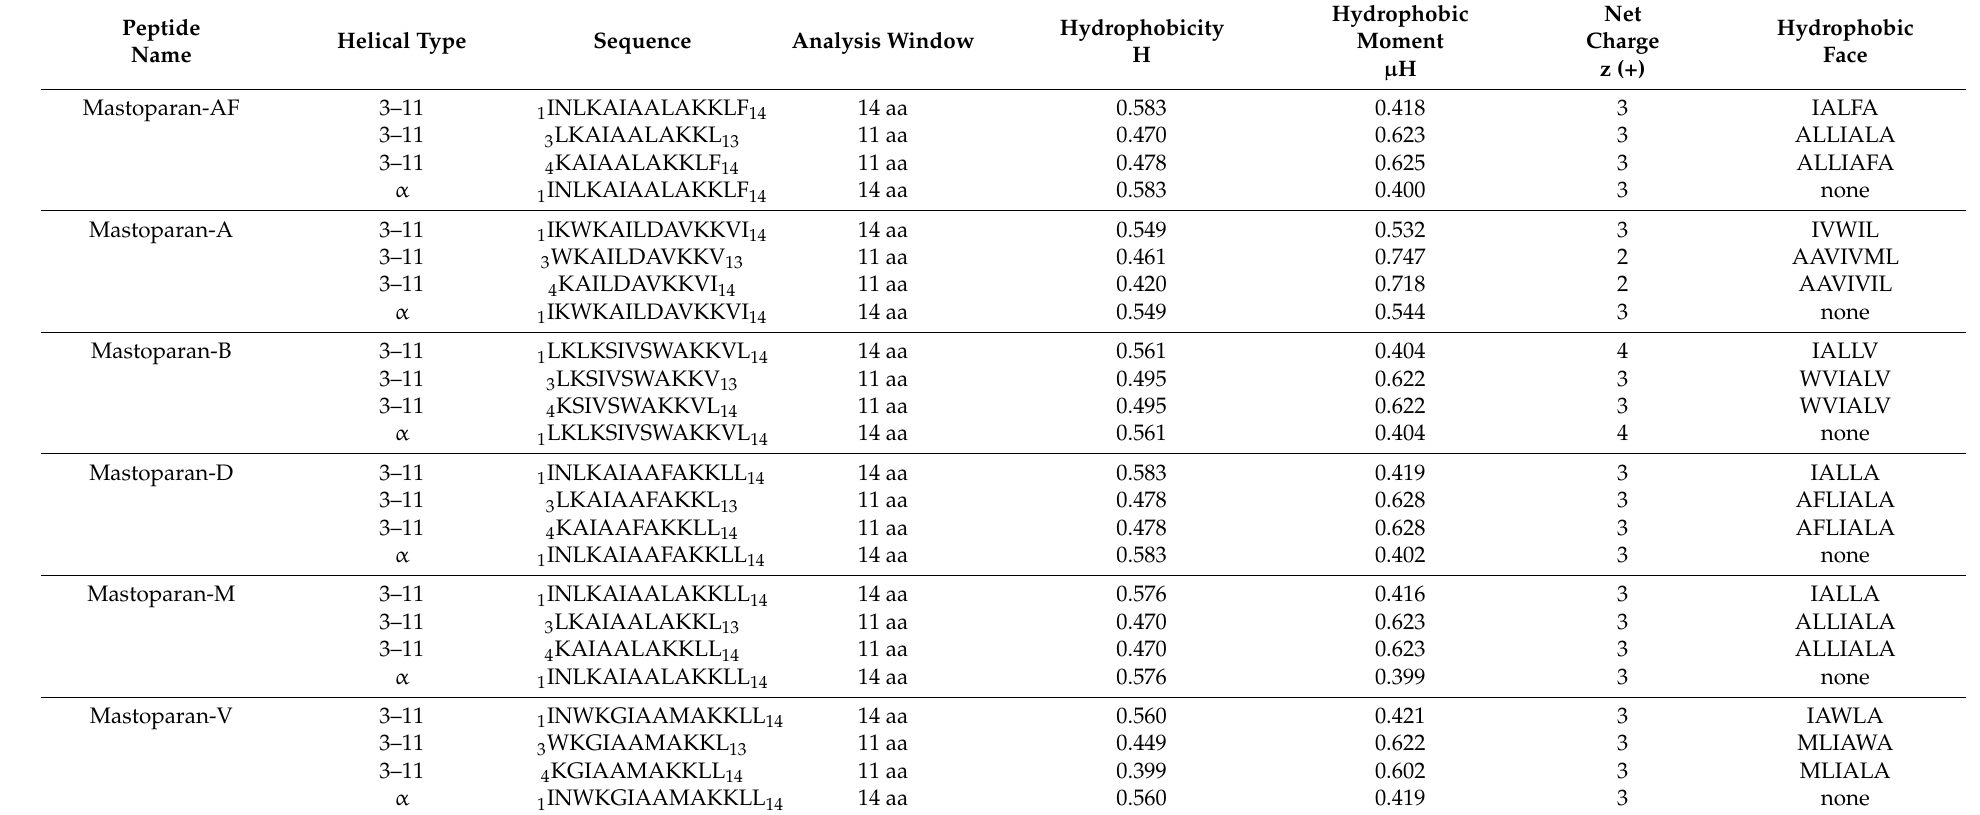
Table 3. Helical types and physicochemical properties of